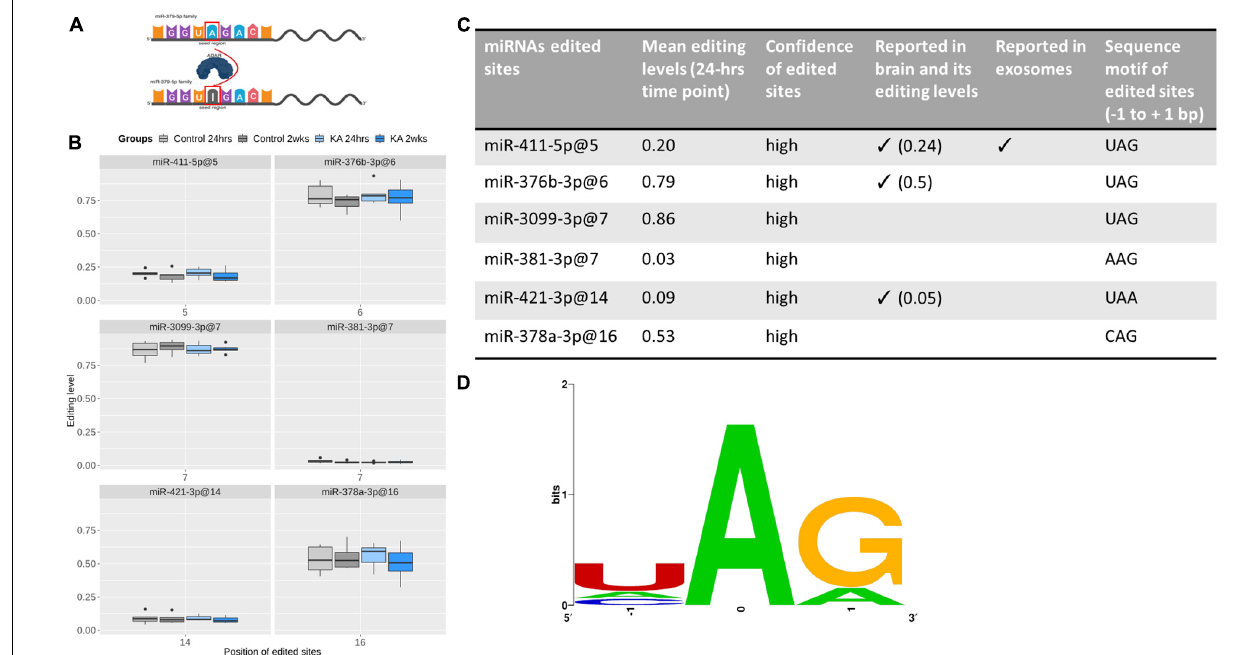
FIGURE 8 | RNA editing of EEF-derived miRNA. (A) Graphic illustration of A-to-I editing, which is catalyzed by ADAR enzymes. miRNA editing can occur in seed regions (as shown here) or outside of the seed regions. This graph was created with BioRender. (B) Boxplots showing the editing levels (median with interquartile range), in control and KA samples at the two different time points for six edited sites detected in EEF miRNAs. (C) The table shows evidence supporting the edited sites and (D) sequence motifs of the edited sites. This shows the nucleotide preferences of all sequences surrounding the six edited sites [three-bases long, with the edited nucleotide Adenosine (A) is centered]. All the six edited sites have preferable sequence motifs for ADAR enzymes, which is (1) over-represented uridine (U) but depleted guanosine (G) at the nucleotides before the edited sites and (2) over-represented guanosine at the nucleotides after the edited sites. Confidence of edited site (Li et al., 2018) reported in brain (Alon et al., 2012) and reported in exosomes (Nigita et al.,